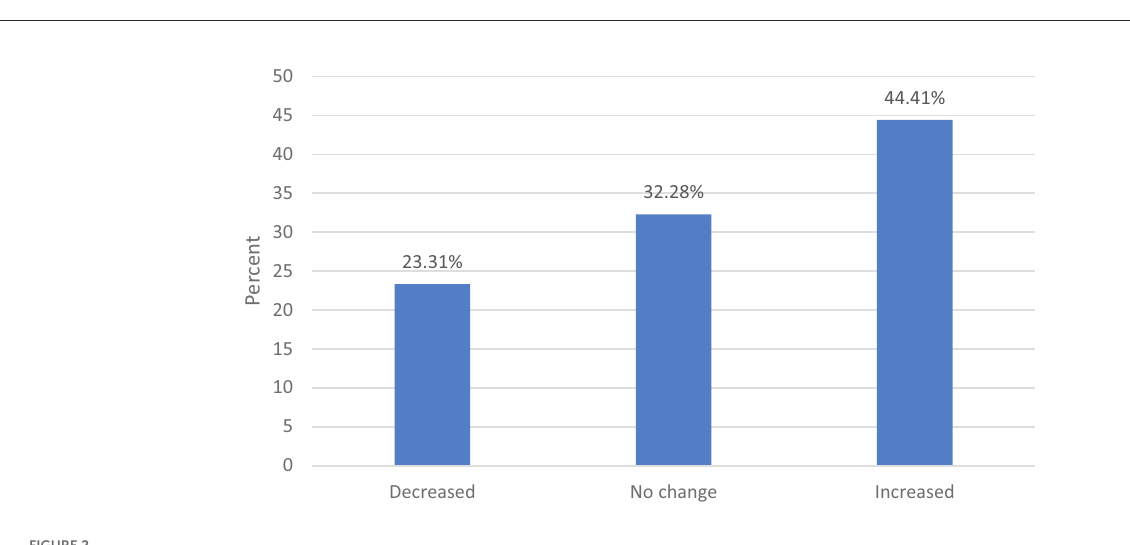
FIGURE2 Participants’ weight changes during the COVID-19 lockdown ( n =